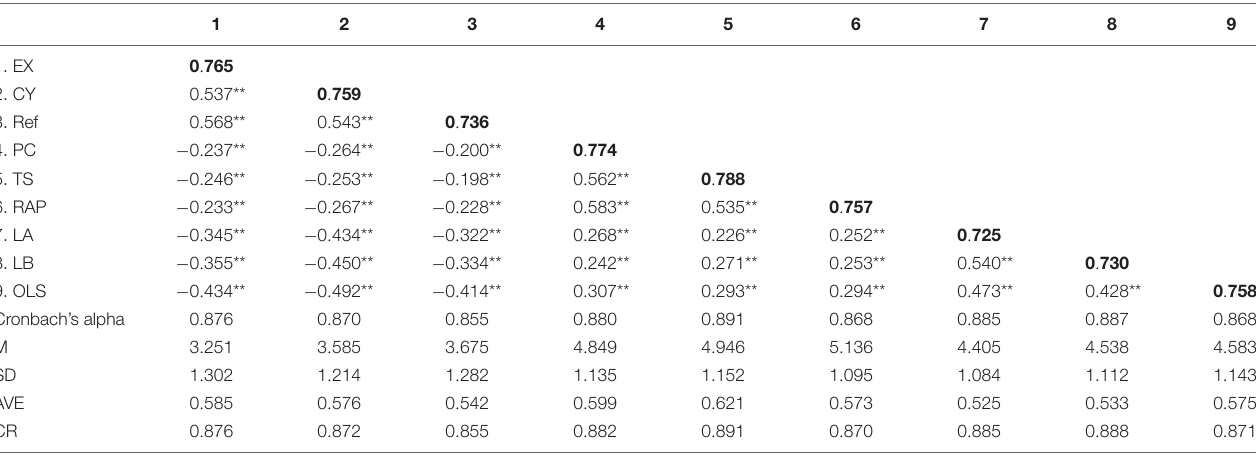
TABLE 1 | Reliabilities, descriptive statistics, and correlations of the